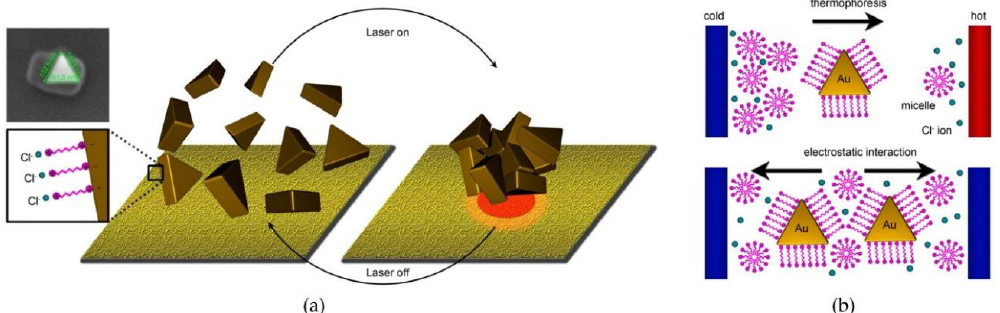
Figure 5. ( a ) Schemes of the laser-induced assembly system of gold nanoplates modified with CTAC; and ( b ) the movement of the nanoplates induced by thermophoresis on the substrate. Reproduced with permission from Reference [62] (Copyright 2016 American Chemical Society).